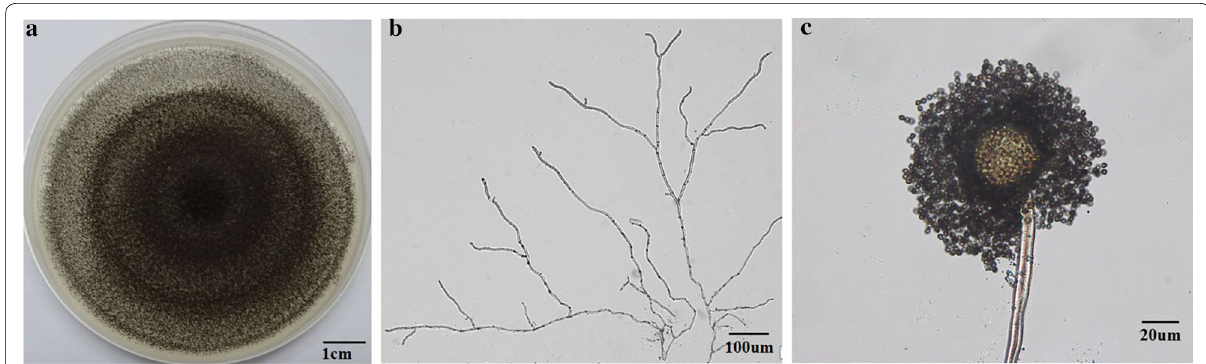
Fig. 3 Morphological characteristics of A. tubingensis XG21. a Growth on PDA medium at 30 °C for 6 days. Scale bar 1 cm. b Microscopic observation of the XG 21 mycelium grown on CD plate. Scale bar 100 μm. c Conidiophore and conidia. Scale bar 20 μm